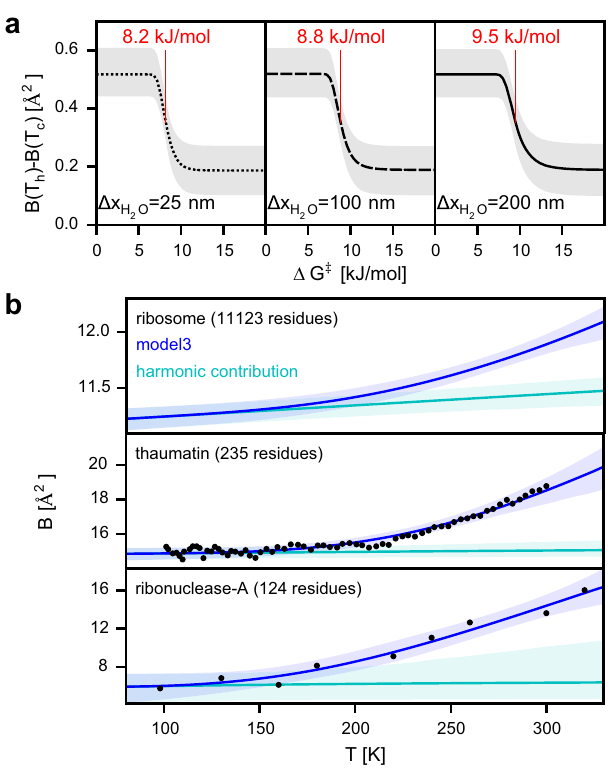
Fig. 4 B-factor dependency on barrier height and temperature. a Difference between B-factors at the temperatures before cooling ( T h ) and after cooling ( T c ) calculated from model3 as a function of barrier height Δ G ‡ for different water-layer thicknesses ( Δ x ). The Δ G ‡ values at which H 2 O the B-factor is reduced halfway between the reduction at 0 kJ/mol and 20 kJ/mol is indicated in red. Lines denote expected values and gray areas correspond to the 95% con fi dence intervals (obtained from bootstrapping the parameter distributions). b B-factors as a function of temperature calculated from model3 under equilibrium conditions (upper panel; expected values: blue lines, 95% con fi dence interval: light blue area). The B-factors of the harmonic potentials are shown in cyan. B-factors obtained from X-ray crystallography at different temperatures (black dots) for proteins thaumatin 60 (middle panel) and ribonuclease-A 40 (lower panel). B-factors calculated from model3 applied to the experimental B-factors (blue and